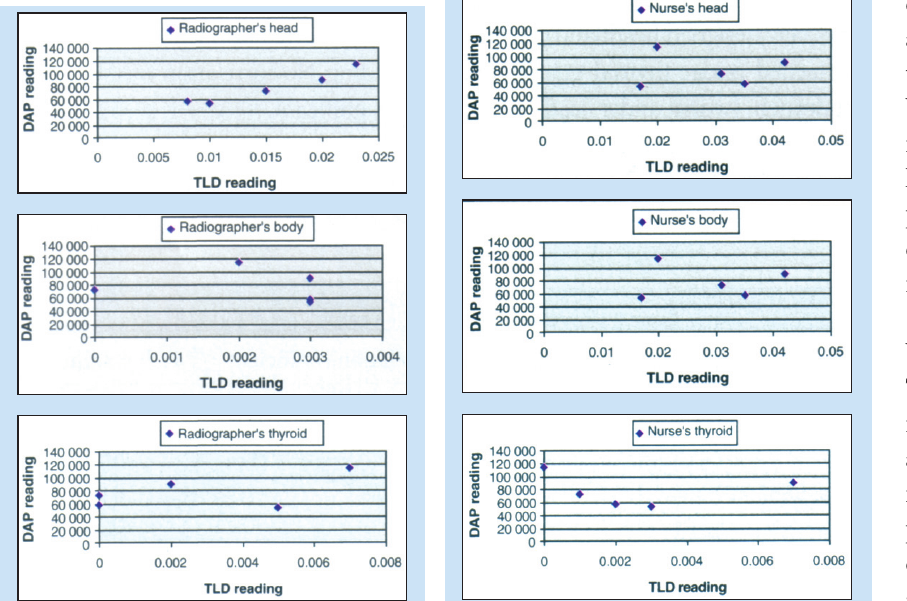
Fig. 3. Correlation between the DAP meter and nurses’TLD meter